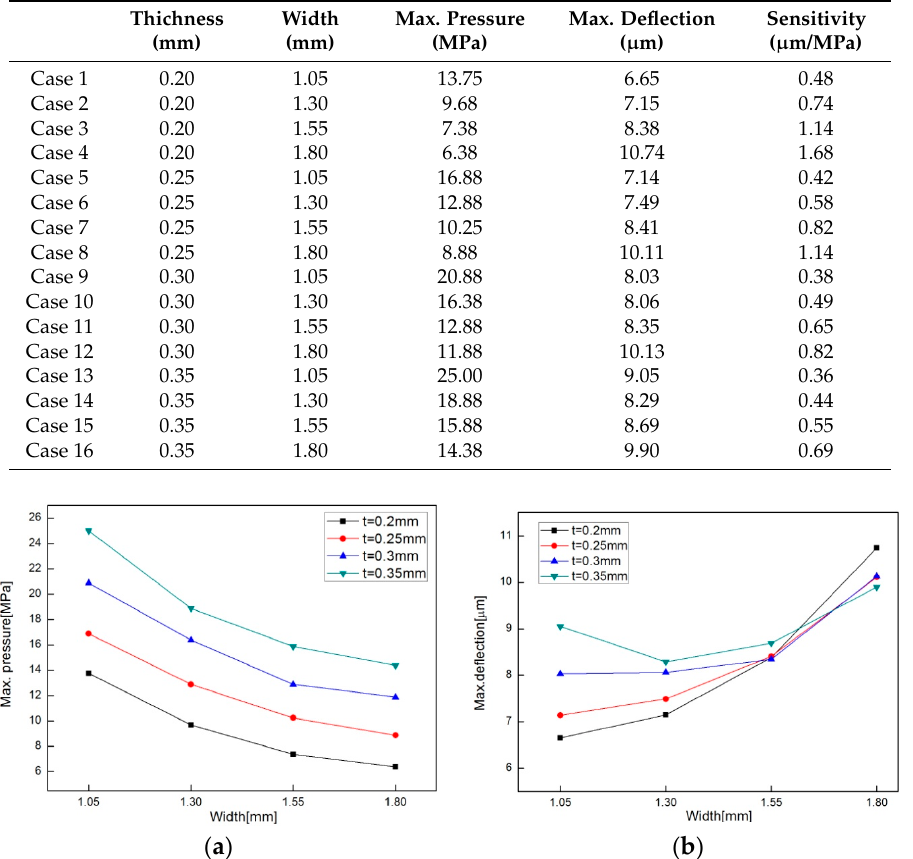
Figure 10. Maximum pressure ( a ) and maximum deflection ( b ) with design parameters of round-groove type.